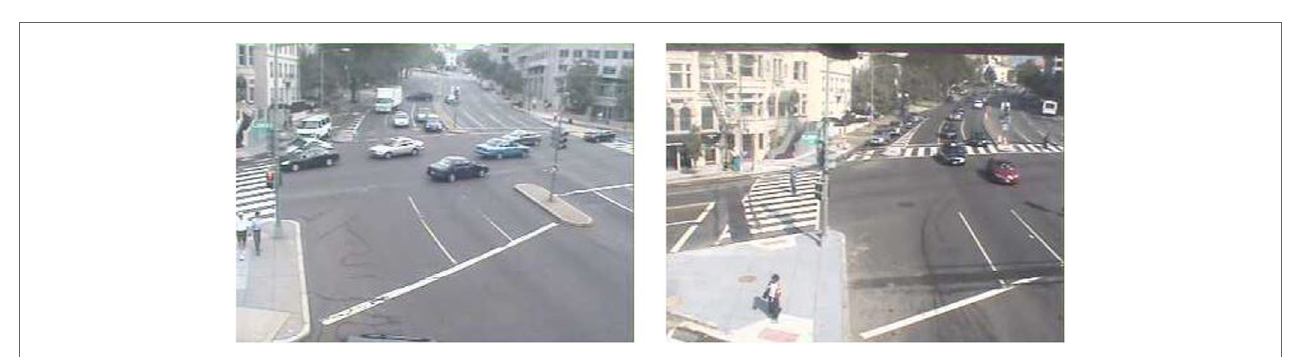
FigUre 2 | commercial intersection prior to (left) and following (right) built environment change .